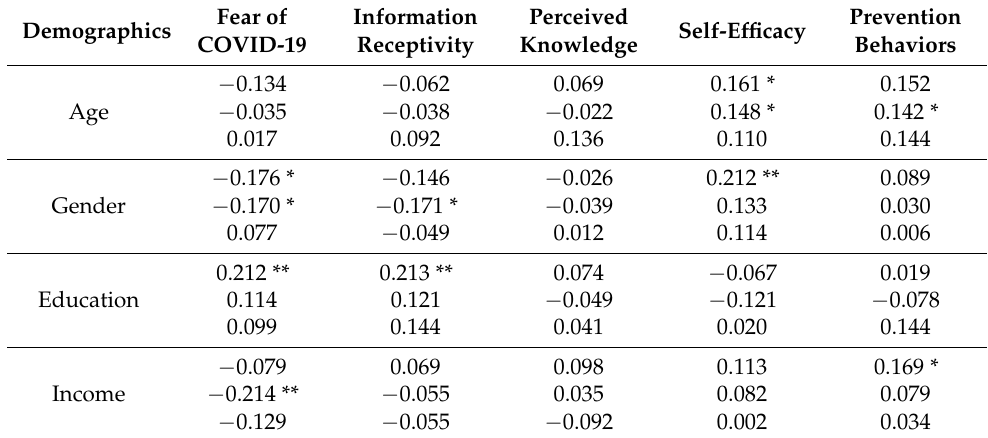
Table 2. Demographic Variables’ Correlation Coefficients with Focal Study Measures.